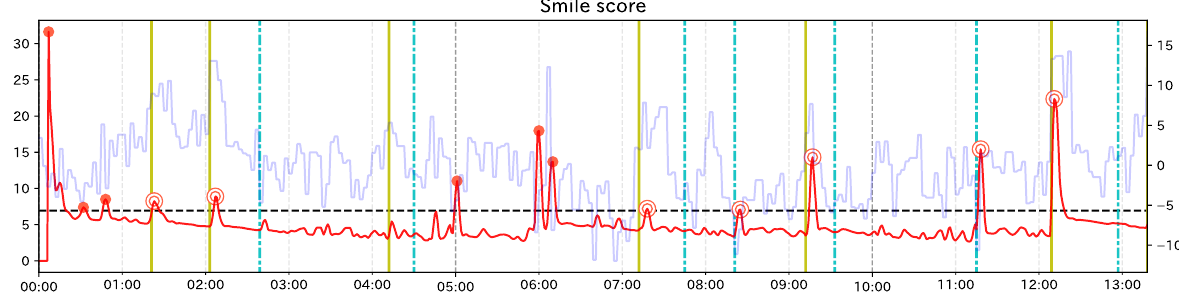
Figure 10. Graph of the change score for Smile scale (Subject